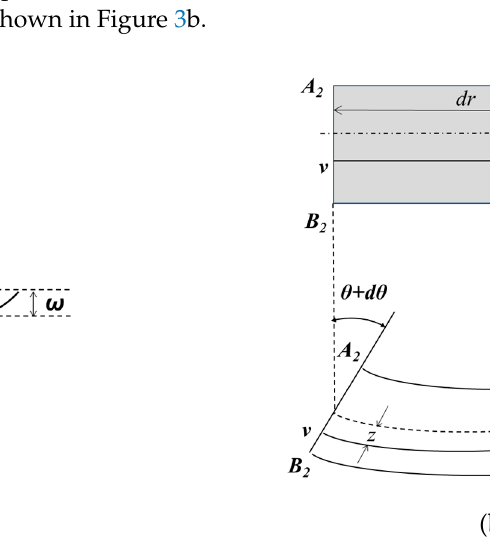
Figure 3. ( a ) Position of θ and ω with respect to the bending plane of the flat plate and ( b ) deflection diagram of the flat plate before and after applying the load.